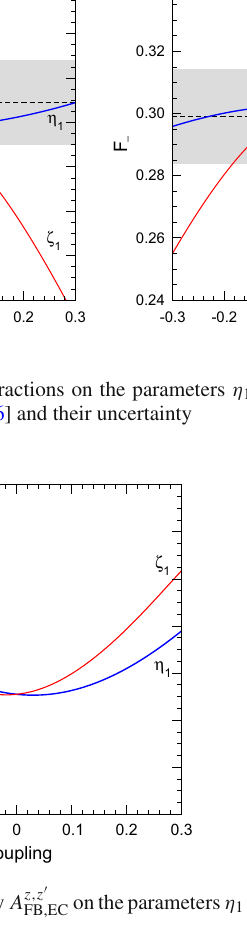
Fig. 2 Dependenceoftheasymmetry A z , z ζ 1 defined in Eq.